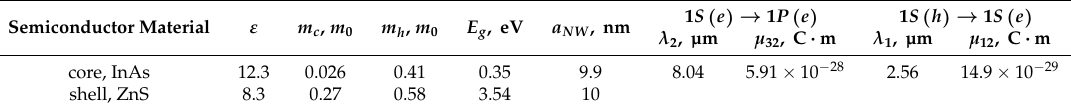
Table 3. The parameters of core–shell NW and transitions in it.